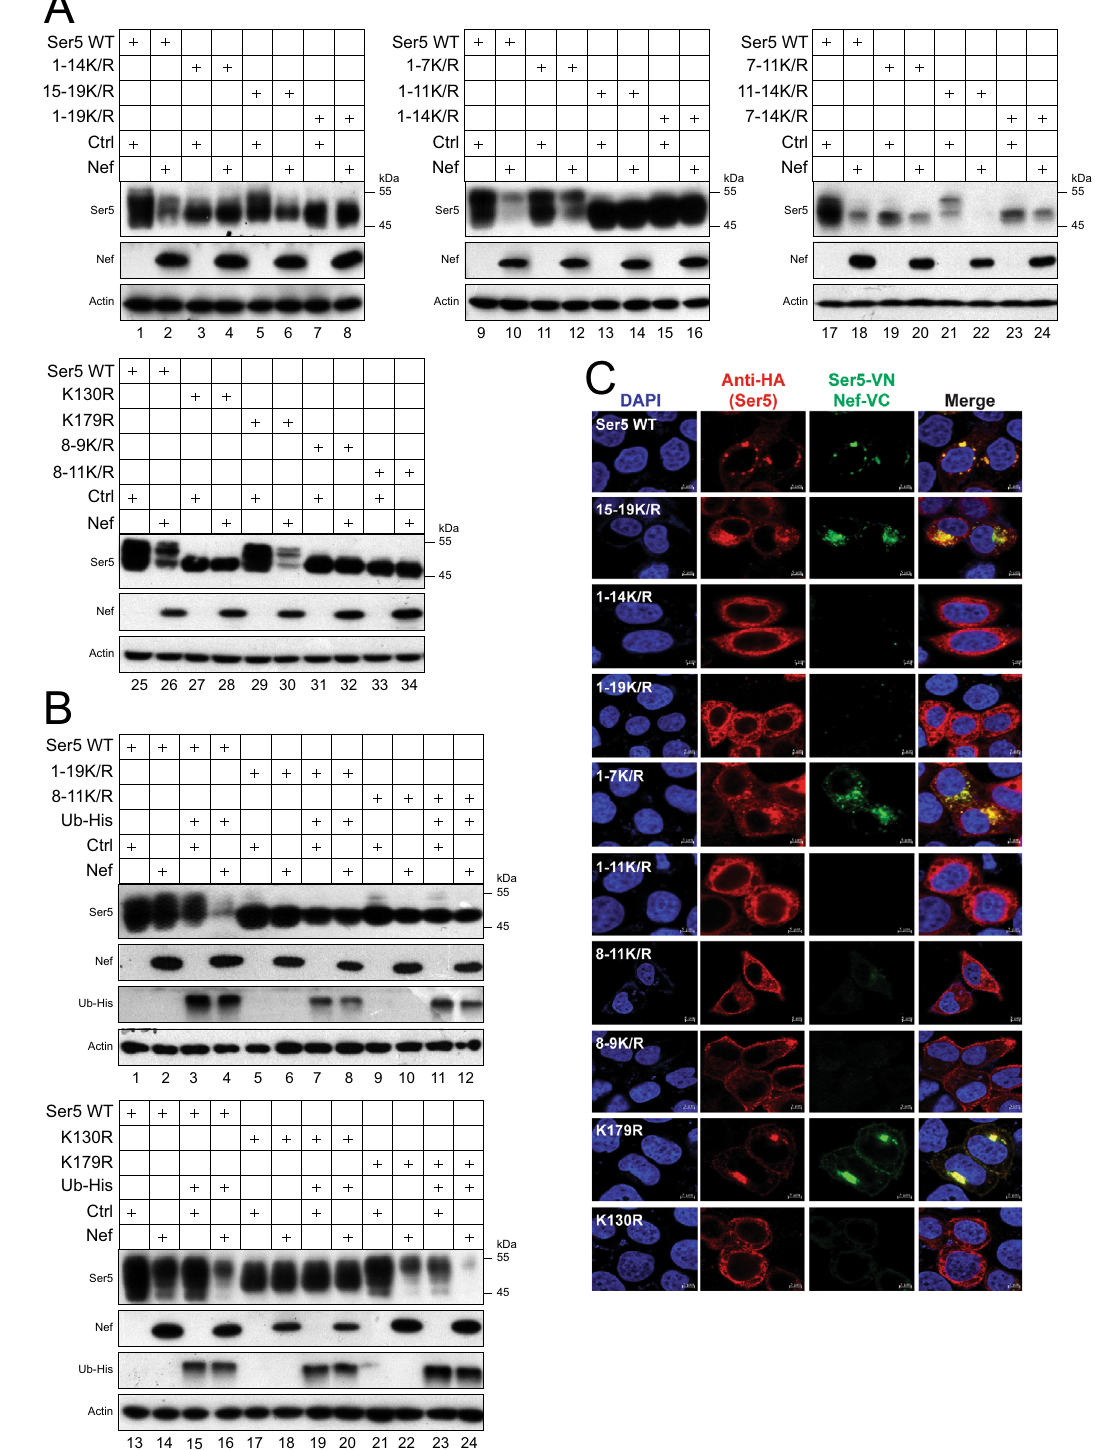
Fig. 5 Polyubiquitination is required for SERINC5 downregulation by HIV-1 Nef. A Ser5 and its lysine mutants were expressed with HIV-1 Nef in HEK293T cells, and their expression was analyzed by WB. Ctrl, control vector. B Ser5 and its lysine mutants were expressed with Ub and Nef in HEK293T cells, and their expression was analyzed by WB. C Ser5-VN and its lysine mutants were expressed with Nef-VC in HeLa cells. Cells were stained with DAPI and anti-HA for Ser5, and BiFC fl uorescent signals were detected by confocal microscopy (scale bar 2 or 5 µ m). Experiments were repeated twice, and representative experiments are shown. Source data are provided as a Source Data fi